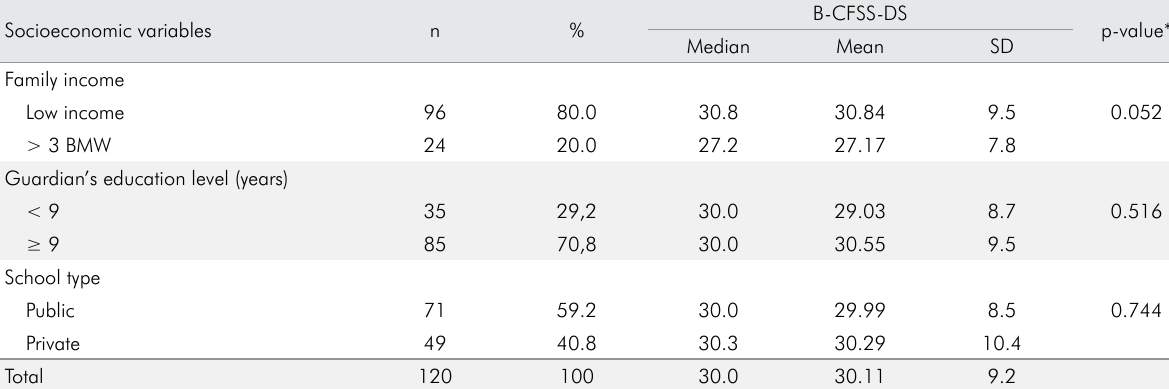
Table 4. Socioeconomic data comparisons according to B-CFSS-DS